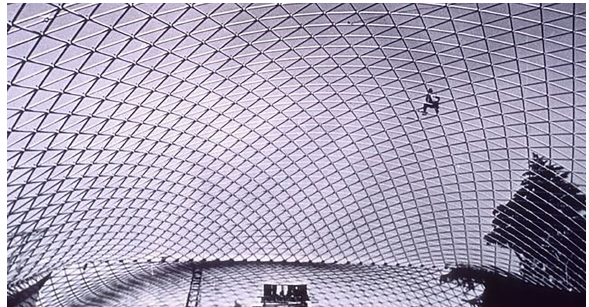
Figure 8: Free-form grid shell by Francisco Castaño. Source: Geomet-